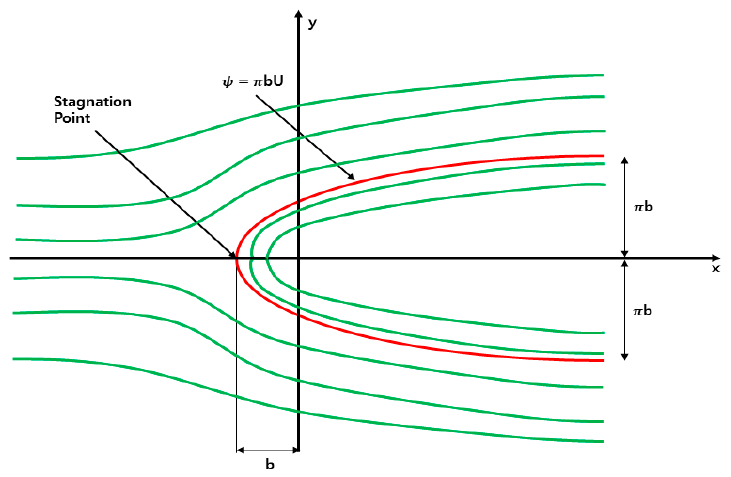
Figure 3. Flow of the Rankine half body.